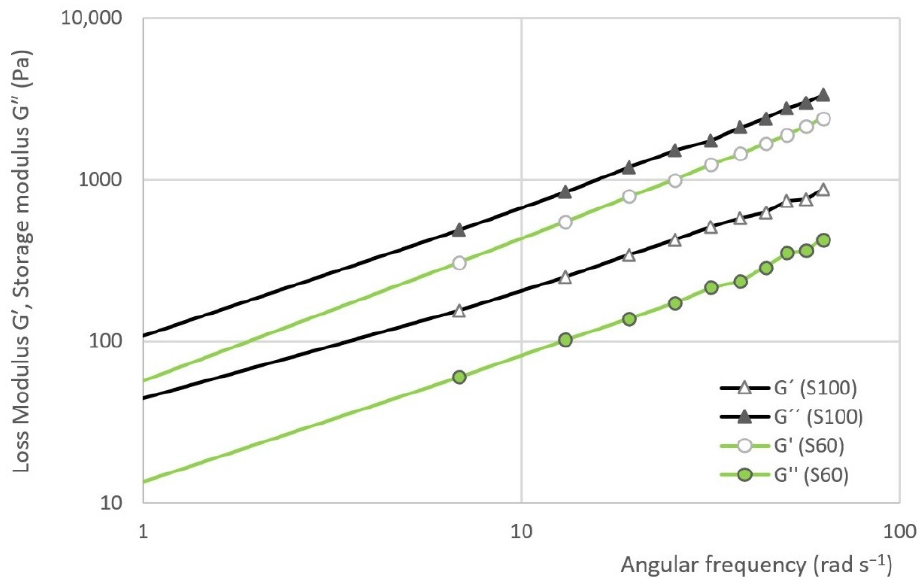
Figure 8. The dependence of the loss modulus ( G (cid:48) ) and storage modulus ( G (cid:48)(cid:48) ) on the angular frequency in the selected samples.